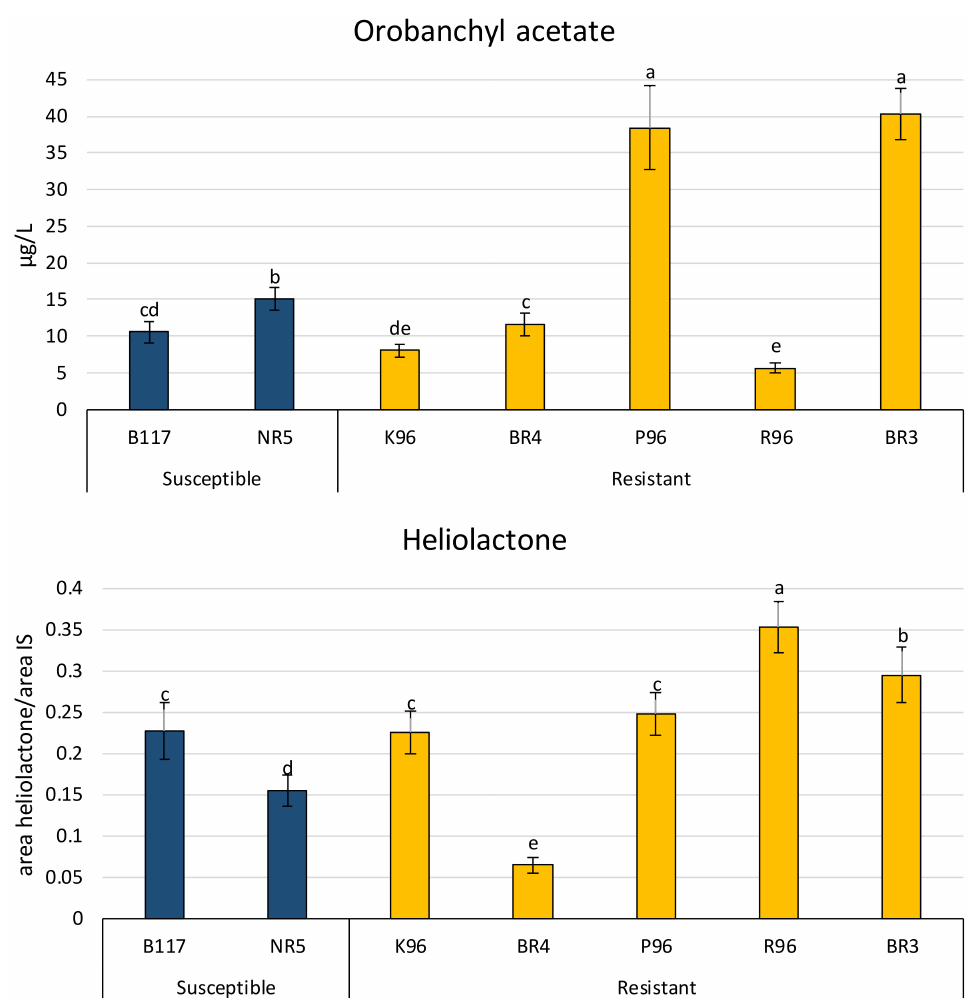
Figure 5. Concentrations of orobanchyl acetate and heliolactone in sunflower root exudates of five resistant varieties (BR4, P96, BR3, K96, and R96) and two susceptible varieties (B117 and NR5). Different letters indicate significant difference ( p < 0.05) according to one-way ANOVA followed by Newman–Keuls test. Similar letters indicate non-significant difference.